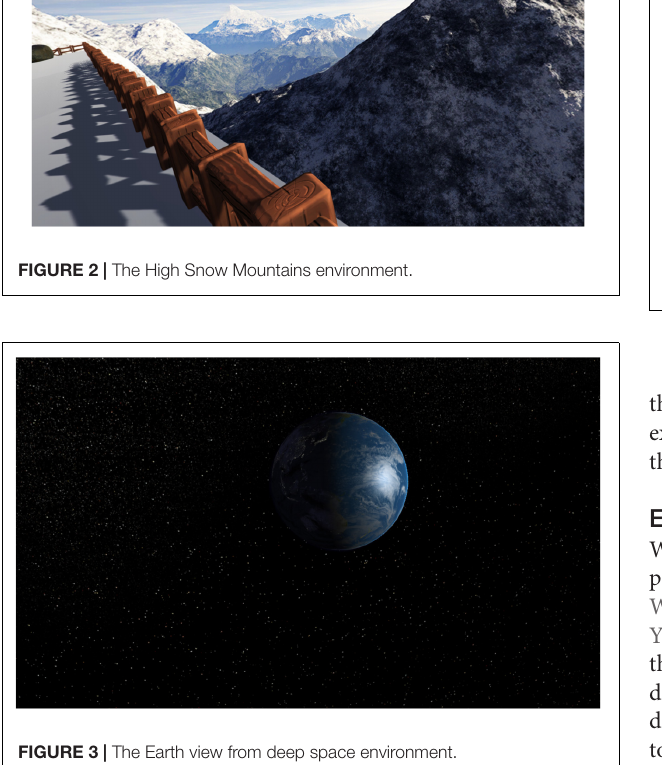
FIGURE 3 | The Earth view from deep space environment.